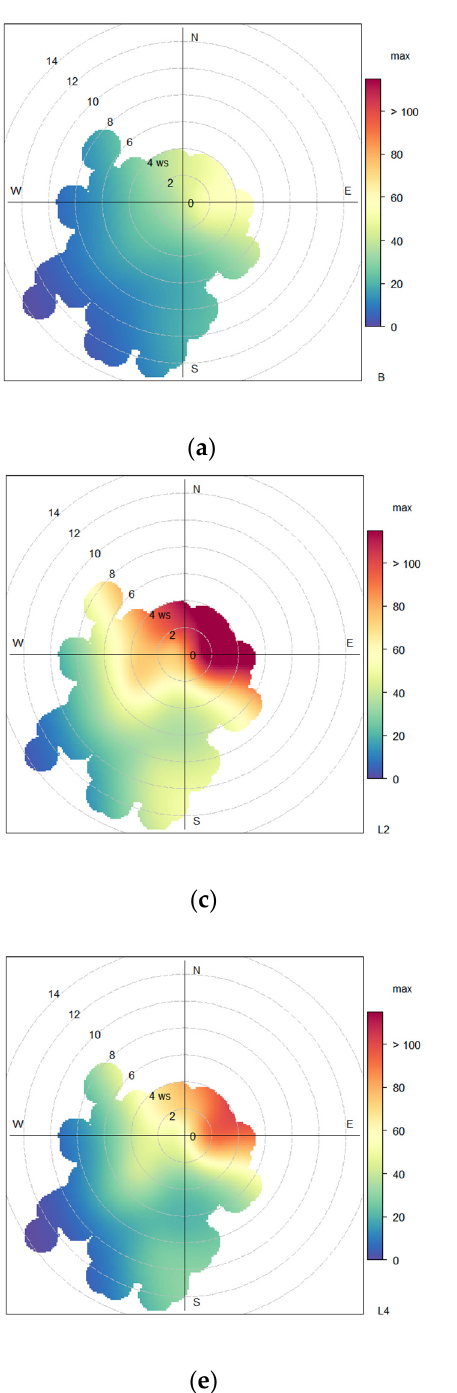
Table 7. Occurrence rates of AQI PM10 and AQI PM2.5 at locations L1–L5.